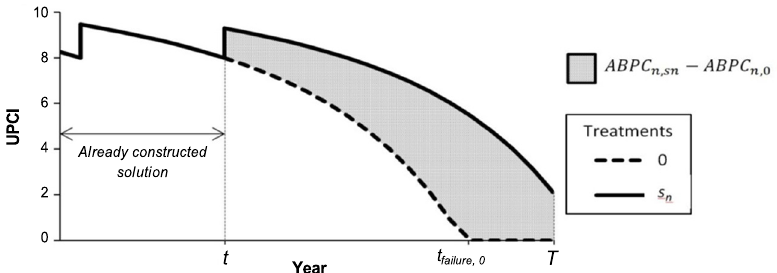
Fig. 2. Effect of the treatment s n to construct the solution in year t with GRASP